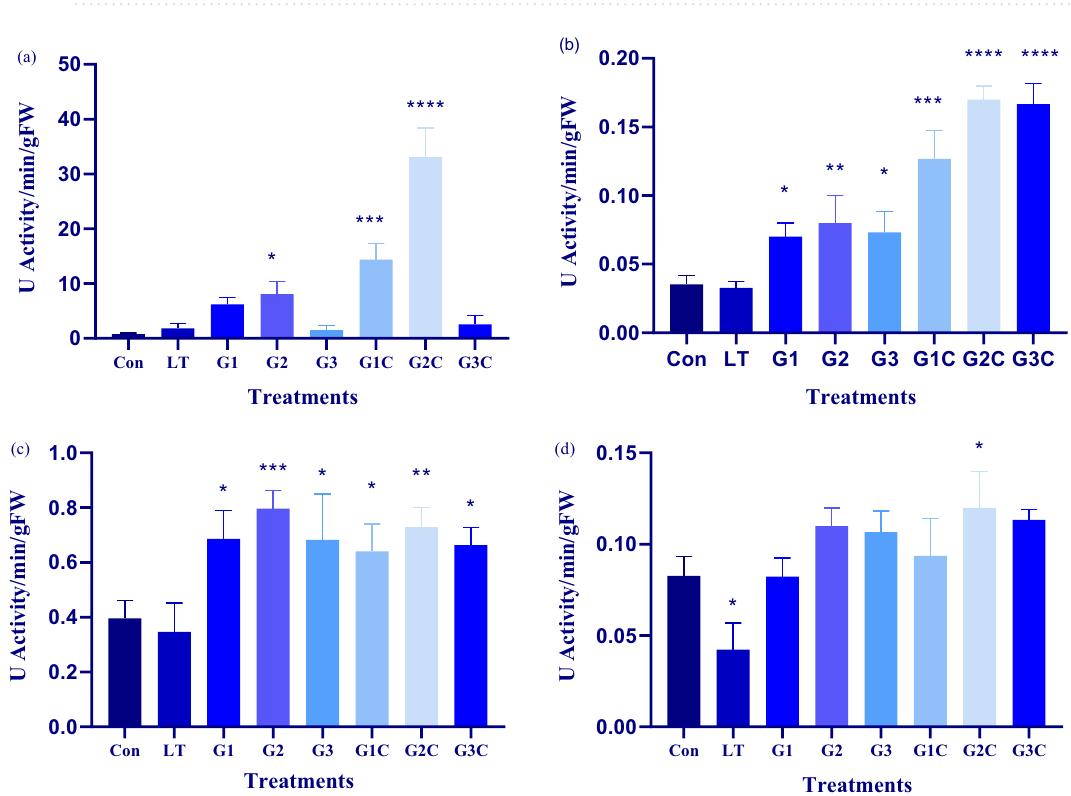
Figure 7. Effect of cold stress and different GSH concentrations on antioxidant activity: Forty days after sowing seedlings were used for experimentation pertaining to LT stress and exogenously applied GSH. Post 3 days recovery determination of antioxidant activities ( a ) CAT ( b ) GR ( c ) SOD (d) APX was carried. The data depicts the mean and standard deviation of three replicates. Data followed by (*) determines level of significance ( p < 0.05) as predicted by Dunnet’s multiple comparison test. Control (Con): 25/18 °C + 0 mM GSH , Low temperature stress (LT): 10/3 °C + 0 mM GSH , G1: 25/18 °C + 0.5 mM GSH , G2: 25/18 °C + 1 mM GSH, G3: 25/18 °C + 2 mM GSH, G1C: 10/3 °C + 0.5 mM GSH, G2C: 10/3 °C + 1 mM GSH, G3C: 10/3 °C + 2 mM